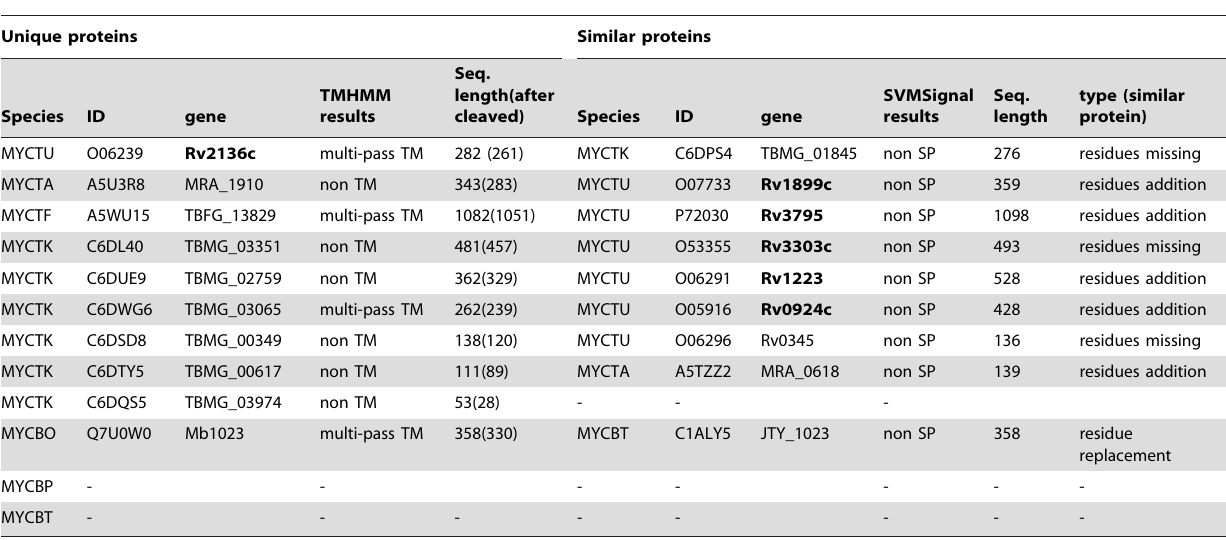
Table 6. List of unique proteins and their similar non-signal peptide